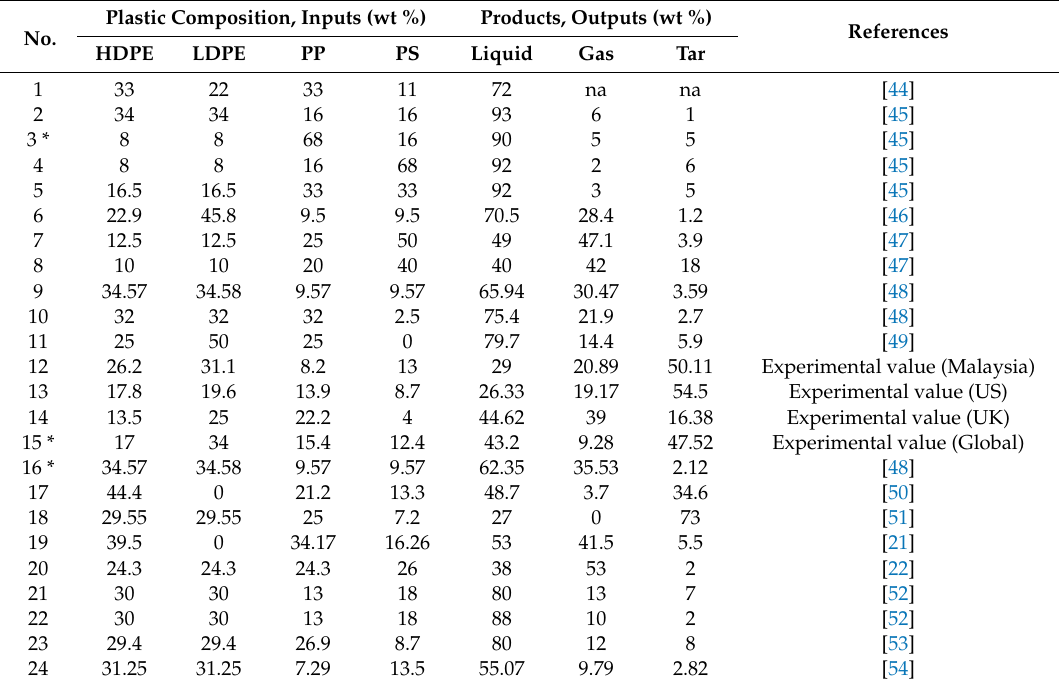
Table 2. Input and output data for artificial neural network (ANN) model